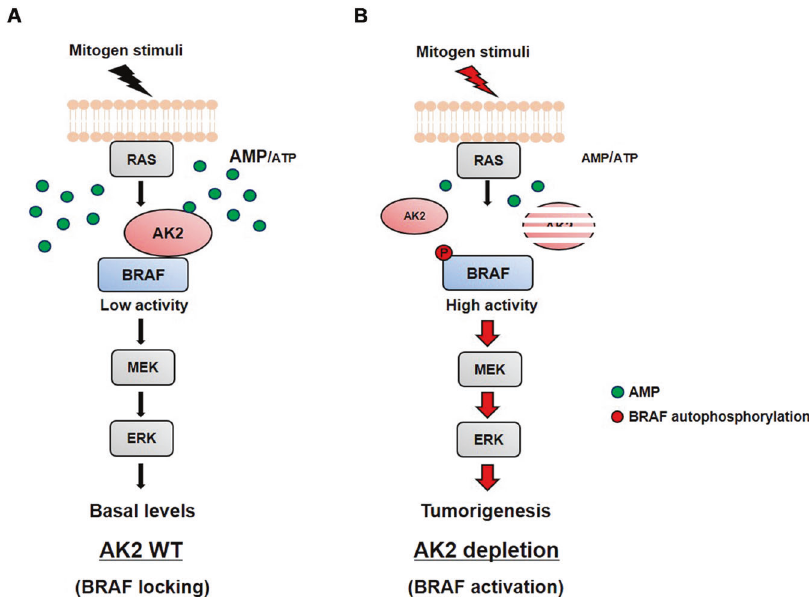
Fig. 7 Proposed model of AK2 function as a BRAF locker in the RAS-BRAF signaling. A Under resting condition with high AMP level, AK2 senses AMP and forms a protein complex with BRAF to inhibit the BRAF activity. B Upon mitogen stimulation and RAS activation, AK2 is released from BRAF, leading to activation of